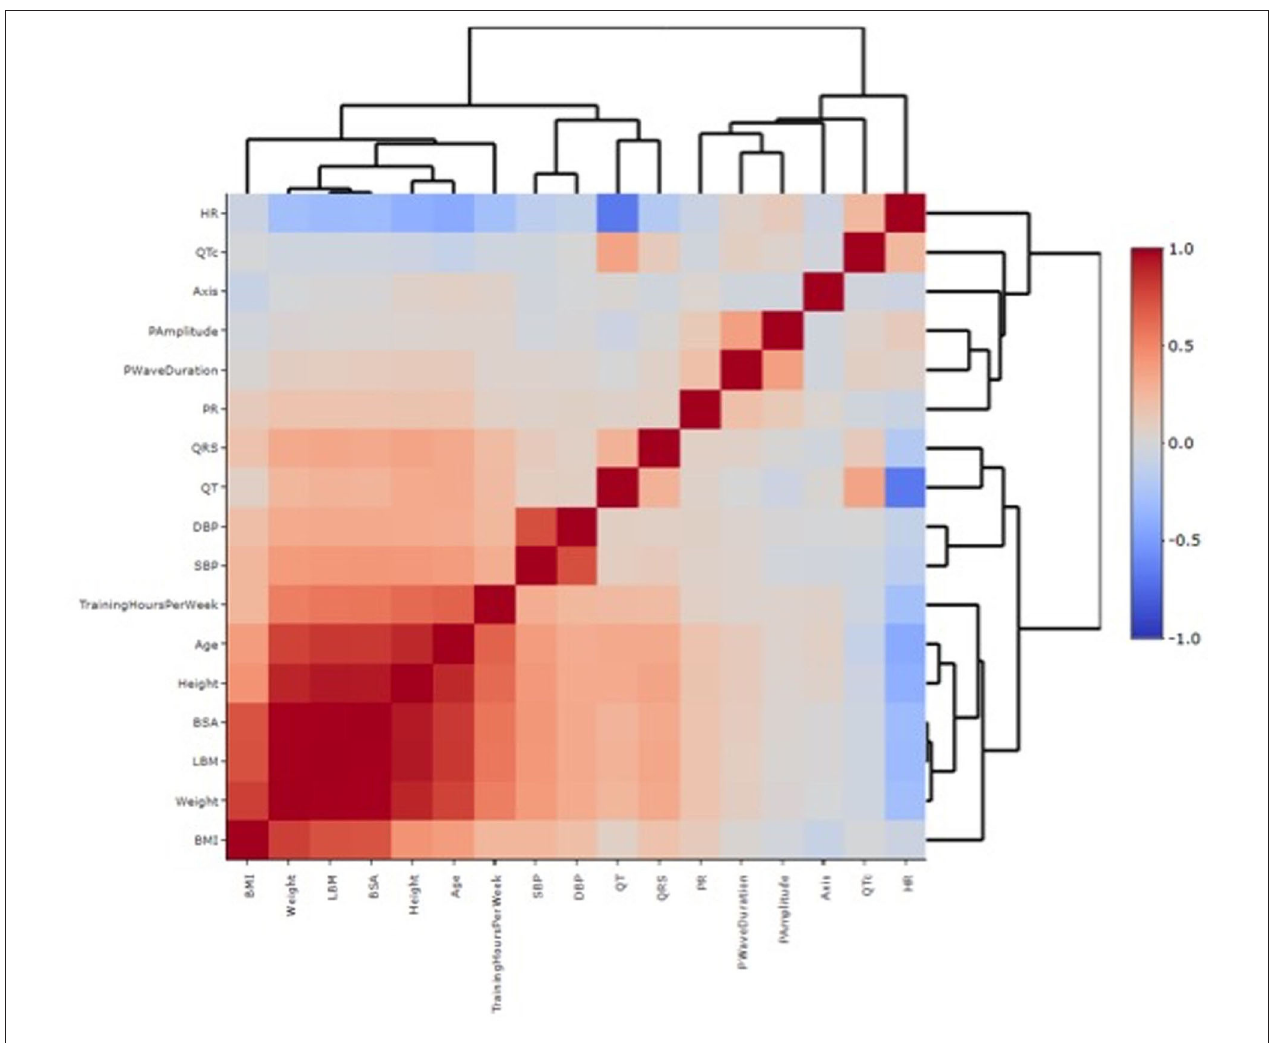
FIGURE 2 | Heatmap correlation between individual features and ECG variables. Each square of the heatmap represents the correlation between the x-axis and the y-axis variables, which ranges between − 1 and + 1. The closer to + 1 the stronger the correlation is (red in the legend, high correlation). The closer to − 1 there is an inverse correlation (blue in the legend). White color represents no correlation. The diagonals are all dark red because the heatmap plot is symmetrical about the diagonal and those squares represent the same variable paired together on both axes. The dendrogram highlights the different clusters in which the study population has been divided based on the different variables